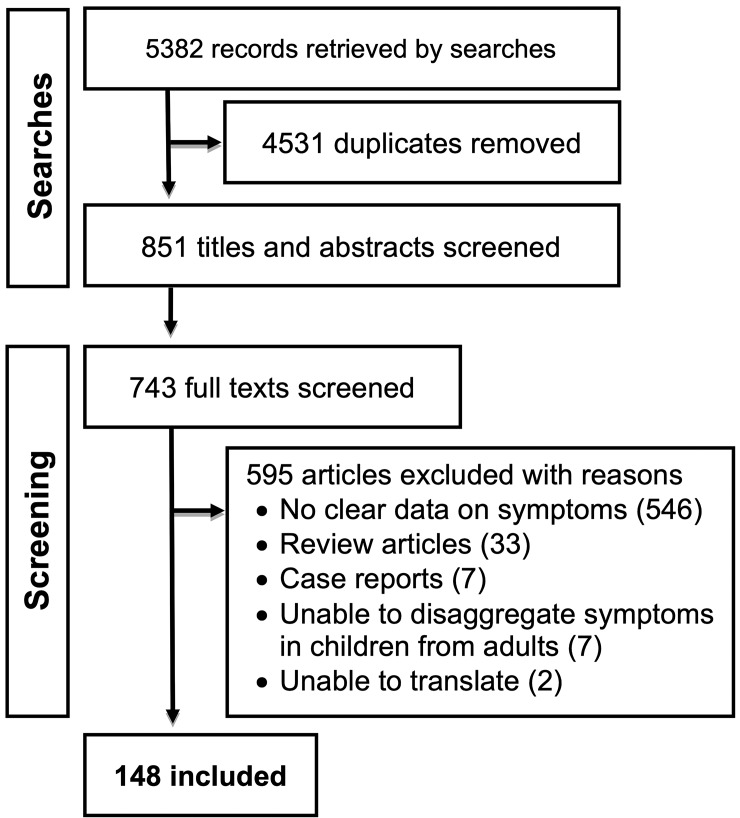
Study flow chart.